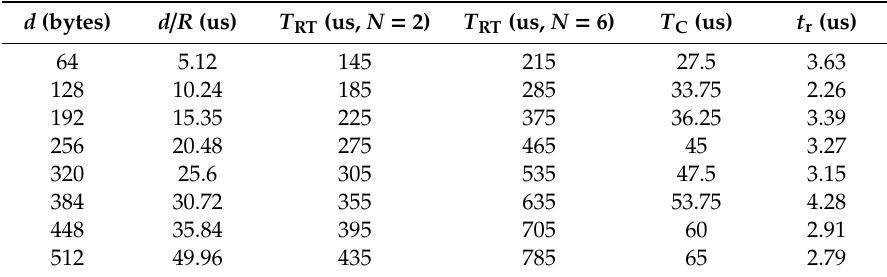
Table 3. Results of round-trip